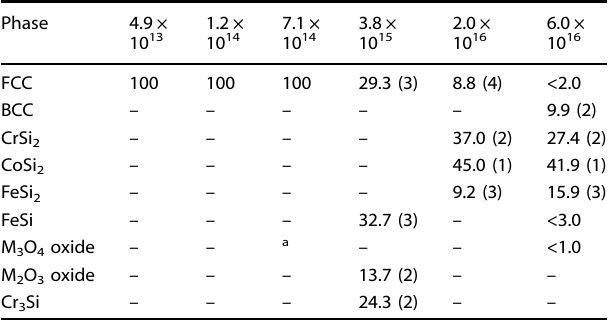
Table 3. Quantitative phase compositions (wt%) of the samples irradiated to different fl